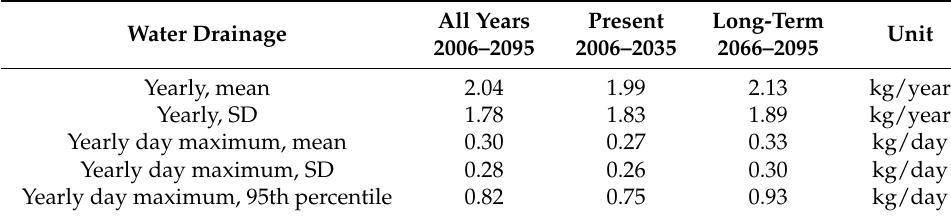
Table 10. Comparing the water drainage in the joint on the south facing facade for all years